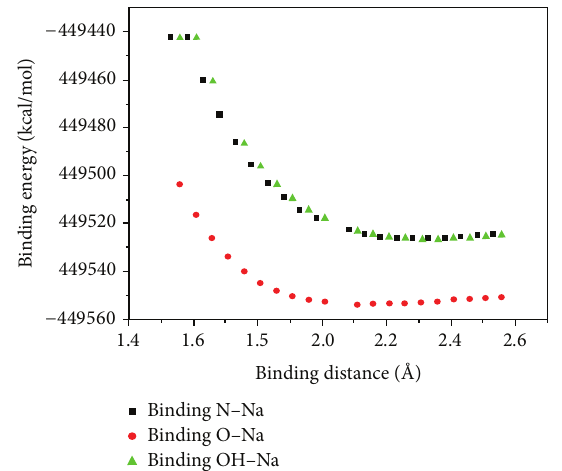
Figure 3: Potential energy curve for the chemical bond between the Na + ion with NH 2 , C=O, and OH groups.